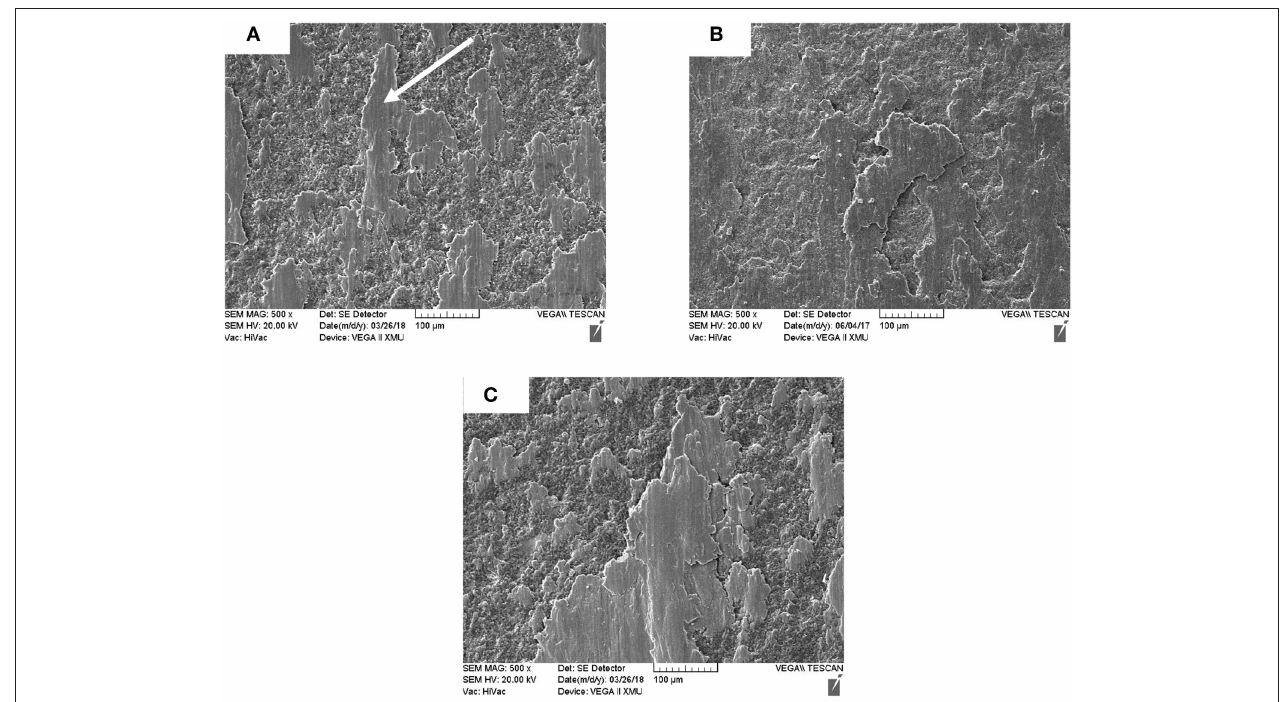
FIGURE 7 | EDS results of transferred layer on the Si 3 N 4 pin against titanium alloy disc at a load of 10N.